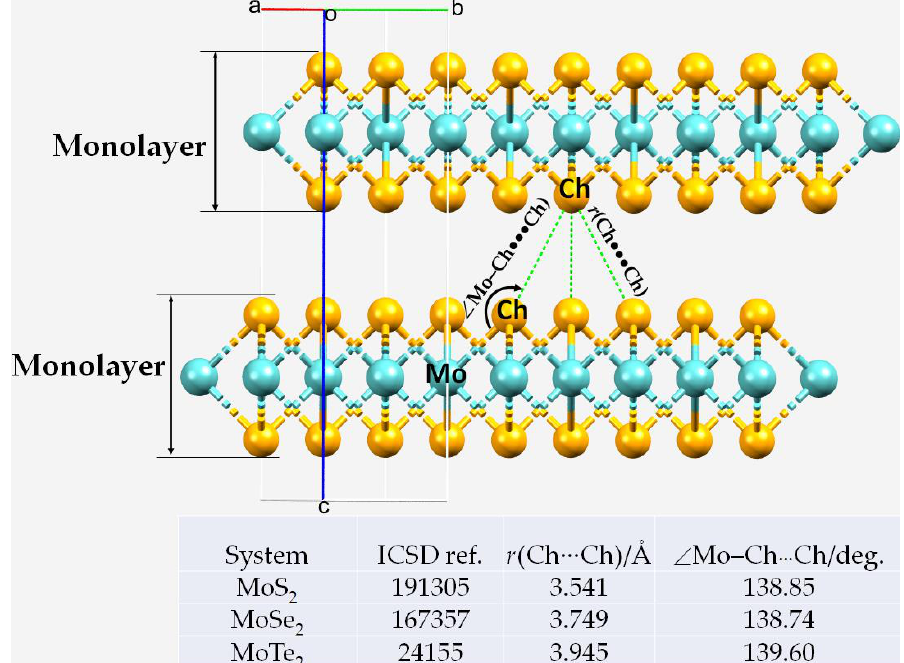
Figure 1. Nature of interfacial bonding interactions between the Mo-bonded chalcogenides in the 1 × 4 × 1 supercell structures of bilayer MoCh 2 (Ch = S, Se, Te). The inset (bottom) summarizes ICSD ref. codes of unit-cells of the three MoCh 2 crystals, including the interfacial bond lengths and bond angles (experimental) corresponding to the Ch ··· Ch